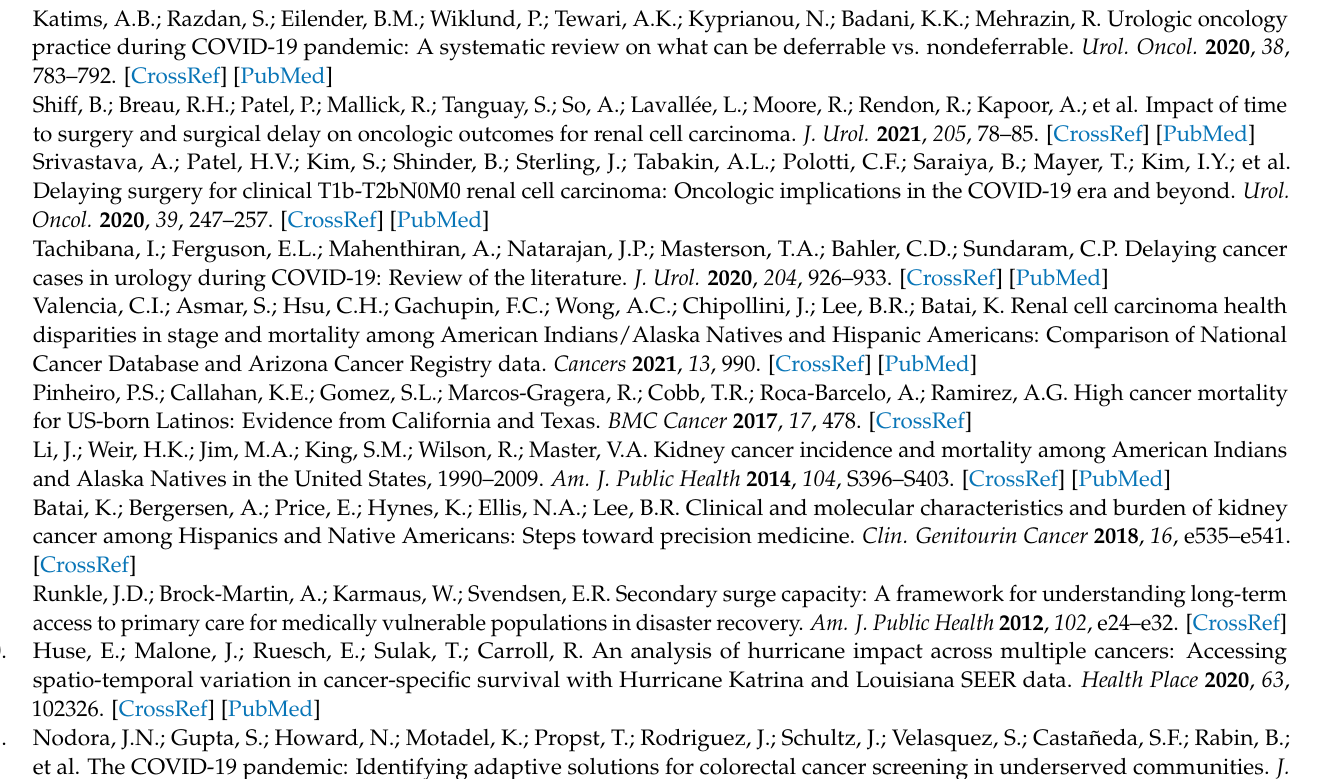
TNM stage, Table S4: Sensitivity analysis for factors associated with longer